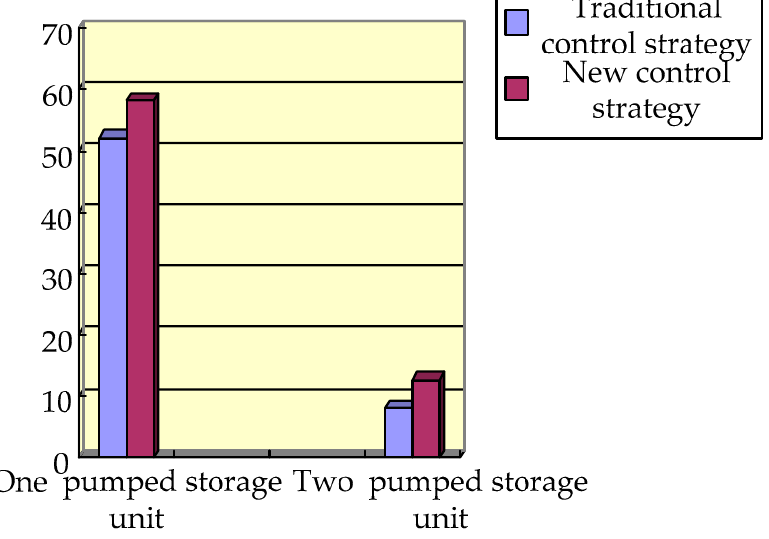
Figure 11. Unit combined power fluctuation under two control strategies.